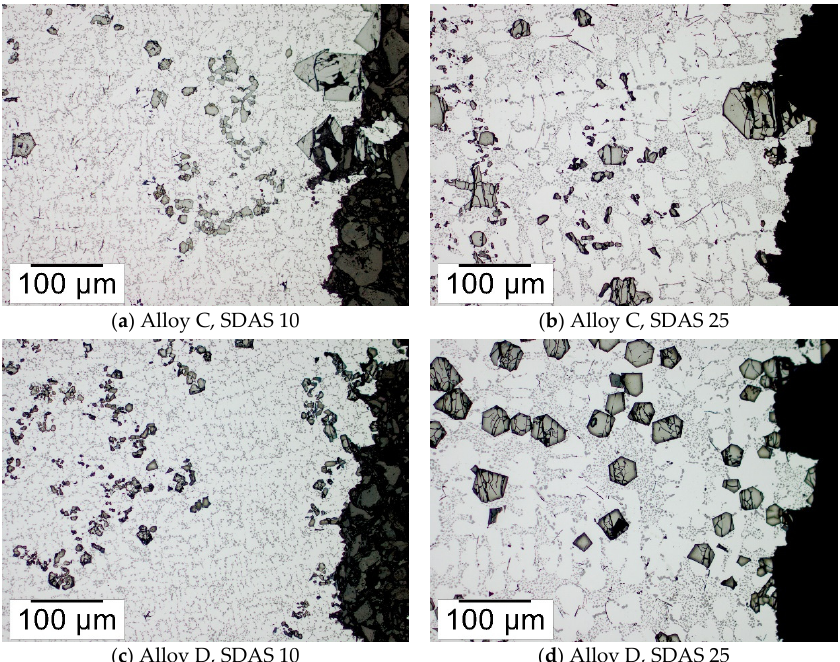
Figure 13. Micrographs of the microstructure towards the fracture surfaces of alloy C in ( a , b ) and alloy D in ( c , d ). The samples are etched with H 2 SO 4 in order to highlight the Fe ‐ rich particles.